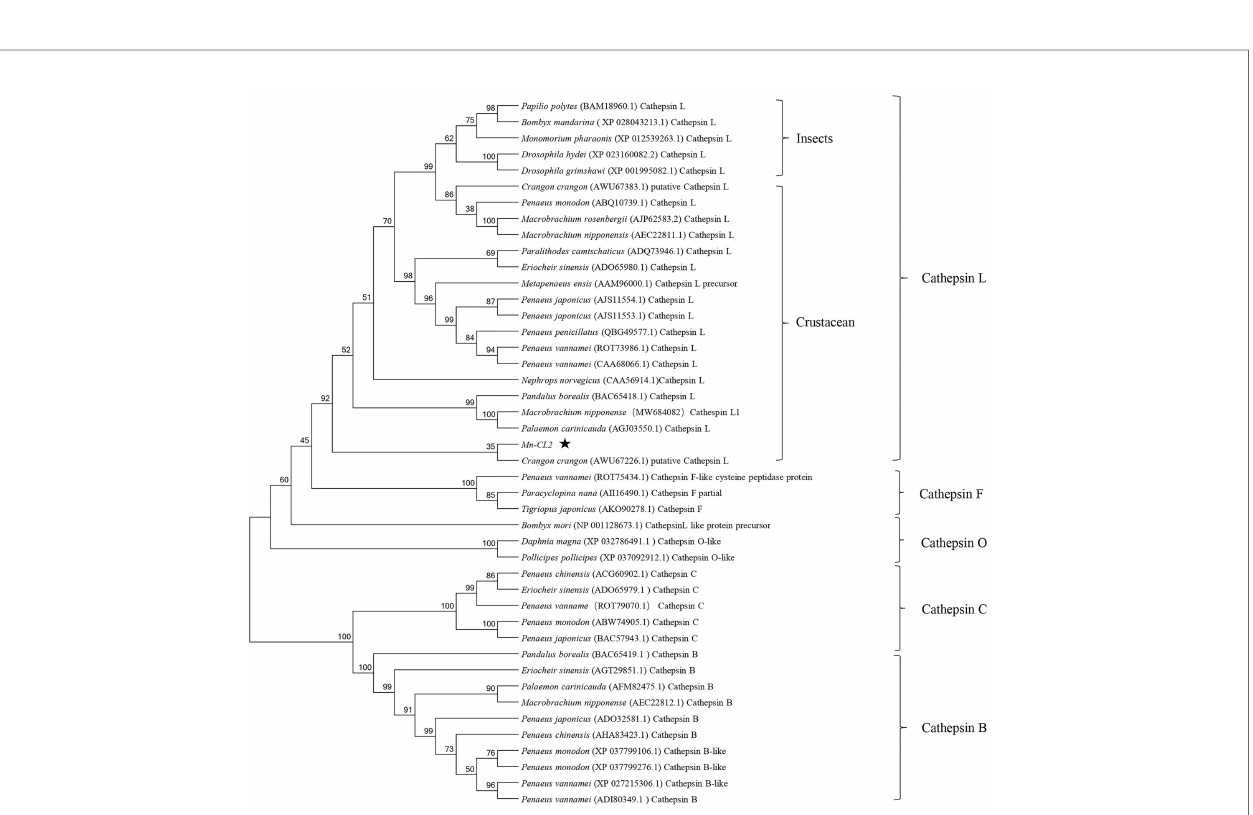
FIGURE 2 | Multiple amino acid alignment and structure prediction of Mn-CL2 amino acid sequence with cathepsin L from other crustaceans. Cathepsin L1 of M. nipponense , MW684082; Cathepsin Ls ( M. nipponense , AEC22811.1; M. rosenbergii , AHW49157.1; Litopenaeus vannamei , CAA68066; P. camtschaticus , AGJ03550.1; Penaeus japonicus , AJS11554.1; Penaeus monodon , ABQ10739.1; Eriocheir sinensis , ADO65980.1). ERFNIN, GCNGG, and GNFD motifs are represented by black boxes. The active sites are marked with red arrows. The symbol star indicated Mn-CL2